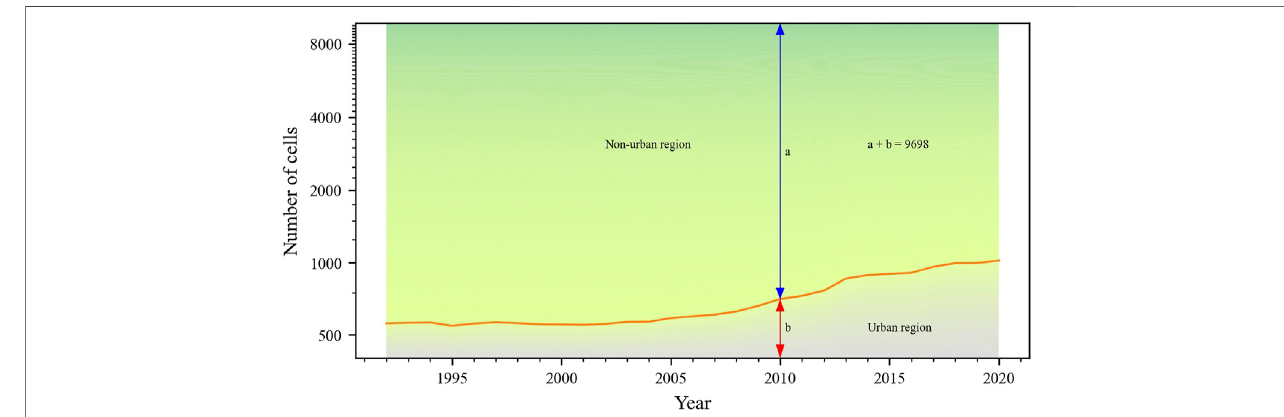
FIGURE 3 | Temporal variations of the sampling grid number for urban and non-urban regions in the YDM. The sum of the grid numbers of urban region and non- urban region always equals to 9,698.